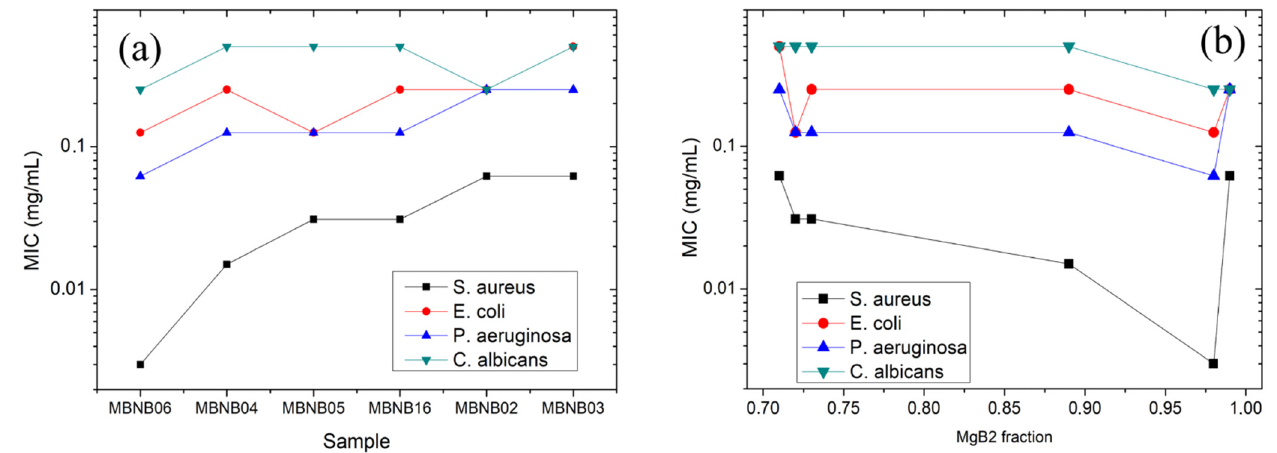
Figure 6. MIC values plotted as ( a ) a function of the overall sample antimicrobial activity (decreasing from left to right) and ( b ) as a function the MgB 2 phase content listed in Table 1.